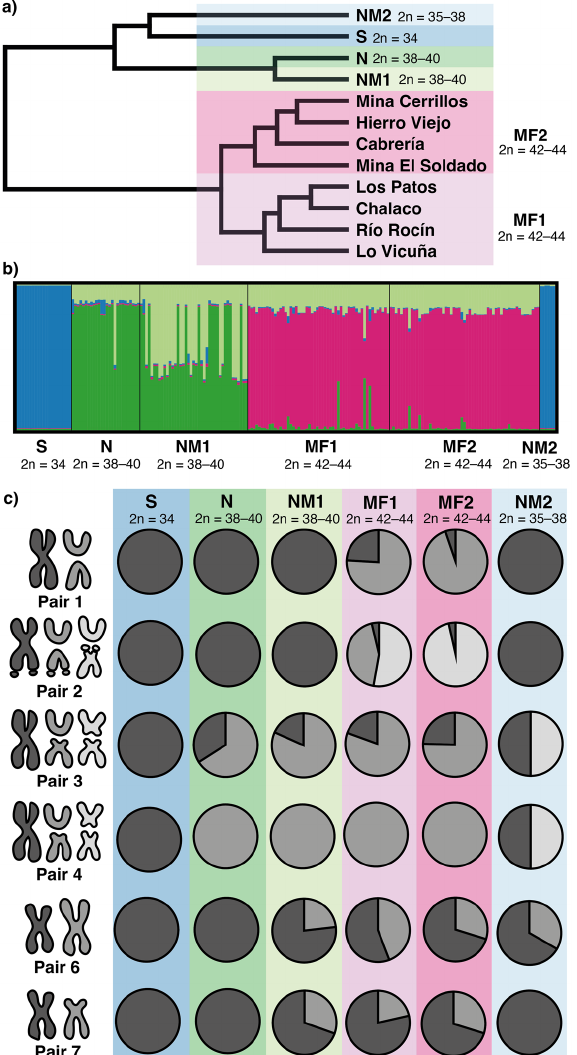
Figure 4. Population cytogenetic analysis of L. monticola . ( a ) UPGMA dendrogram based on Rogers’ genetic distances between localities, showing the six chromosomal races organized geographically from left to right. ( b ) Structure plot based on chromosome alleles for K = 4. ( c ) Allele frequencies for each CR of the first seven chromosome pairs in all races. Allele frequencies were variable between the populations (Figure 4c). All individuals from the Southern race, 2n = 34, were fixed for the ancestral non-fissioned chromosomes in all pairs. The Northern race, 2n = 38–40, was characterized by a high frequency of the fission polymorphism on pair 3, and the fixation of the pair 4 fission. In the NM1 race, 2n = 38–40, an enlarged pair 6 and a pericentric inversion in pair 7 were characteristic of new rearrangements. The Multiple Fission races were characterized by high-frequency poly- morphisms on the fission products of pairs 1 and 2. The main difference between both MF races was that those in the Andean locations (MF1, 2n = 42–44) contained the fission